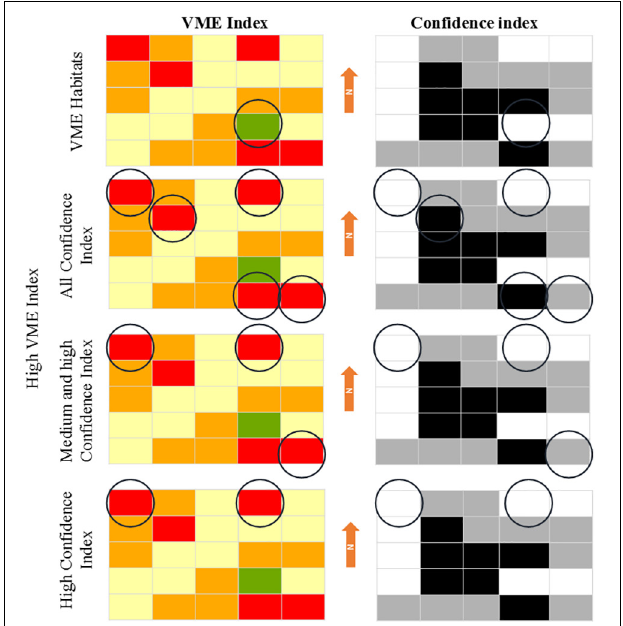
FIGURE 2 | Representation of the usefulness of the VME and Confidence indices maps. The “VME index” hypothetical map contains VME habitats in green, cells with high “VME index” scores in red, medium in orange, and low in yellow. The “Confidence index” map contained cells with high confidence score in white, medium in gray, and low confidence in black. Circles indicate those cells in the hypothetical map that meet the criteria described on the left of the